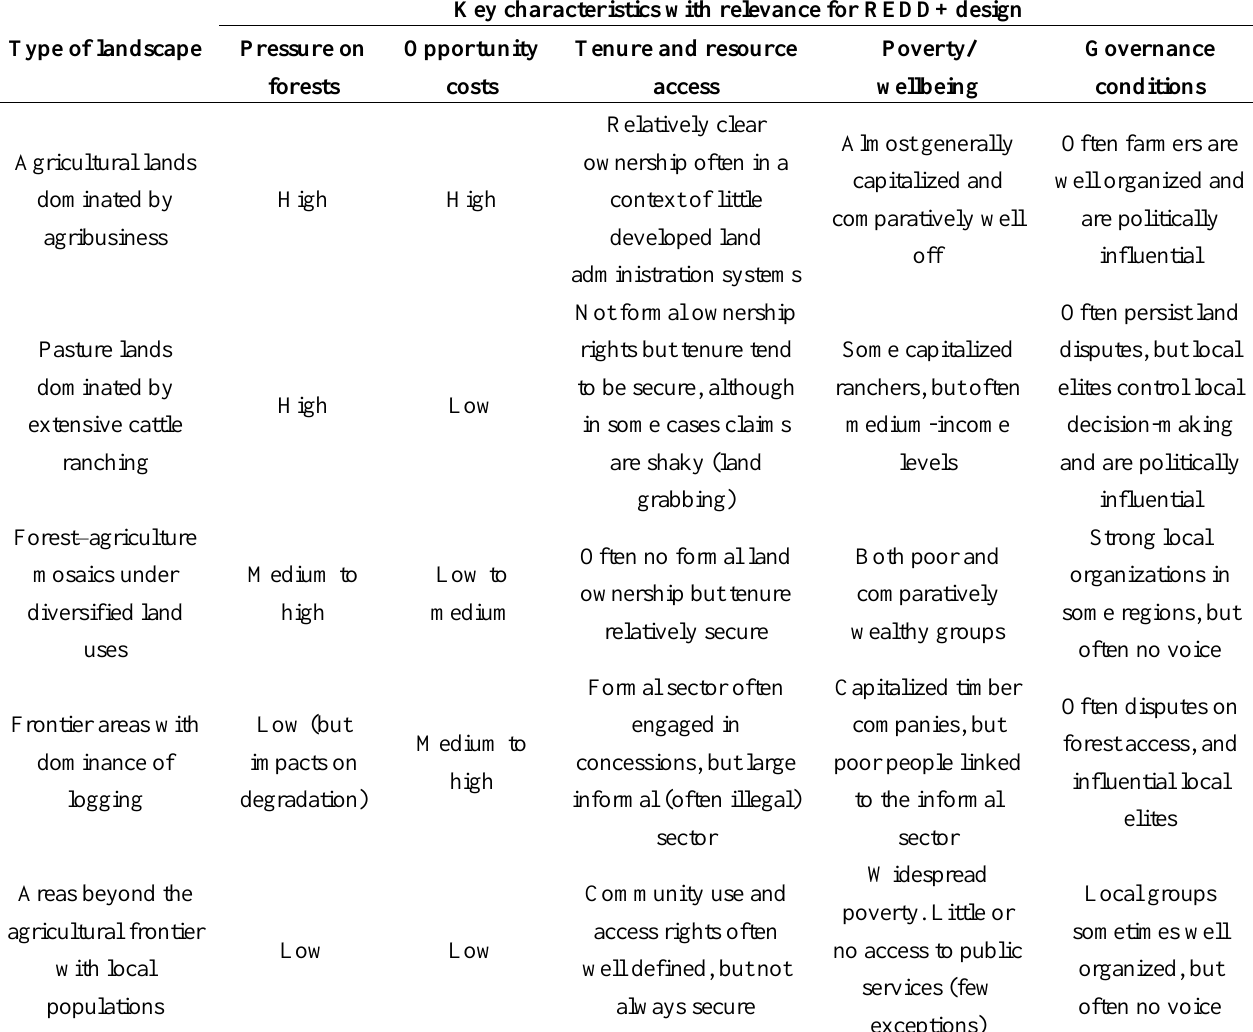
Table 7. Landscape types and key REDD+ design